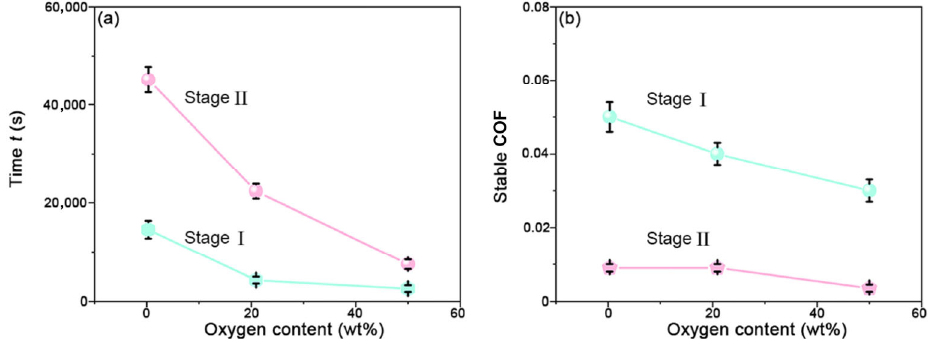
Fig. 3 (a) Time and (b) stable COF at the end of different running-in stages. The error band represents a standard deviation. The average value of each critical time was obtained from three independent friction tests.